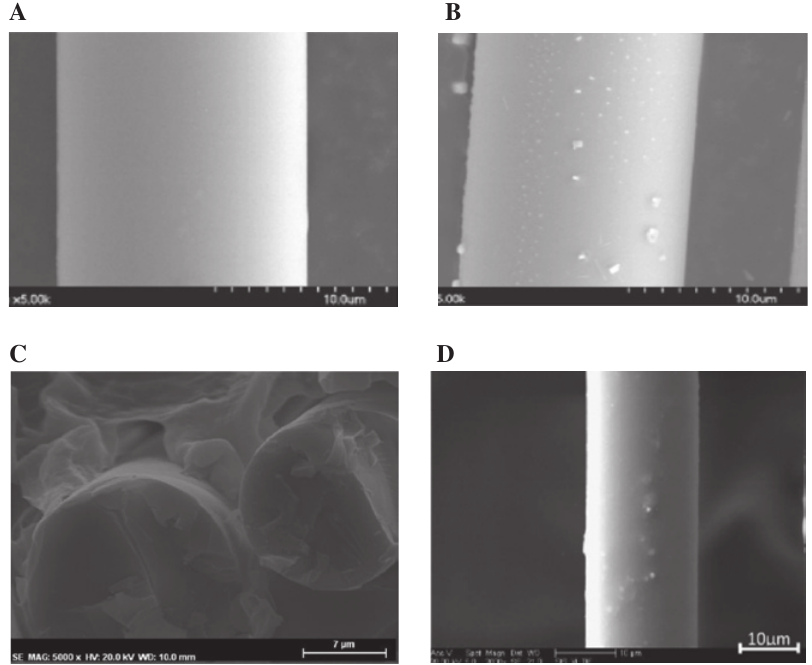
[29], (C) BF/PLA after 2